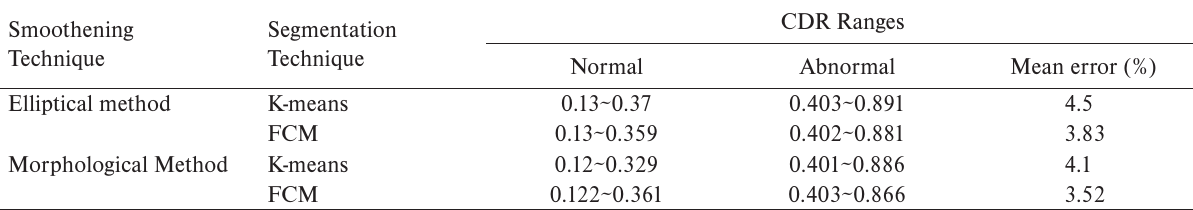
Table 1. CDR ranges and mean error of the proposed method.